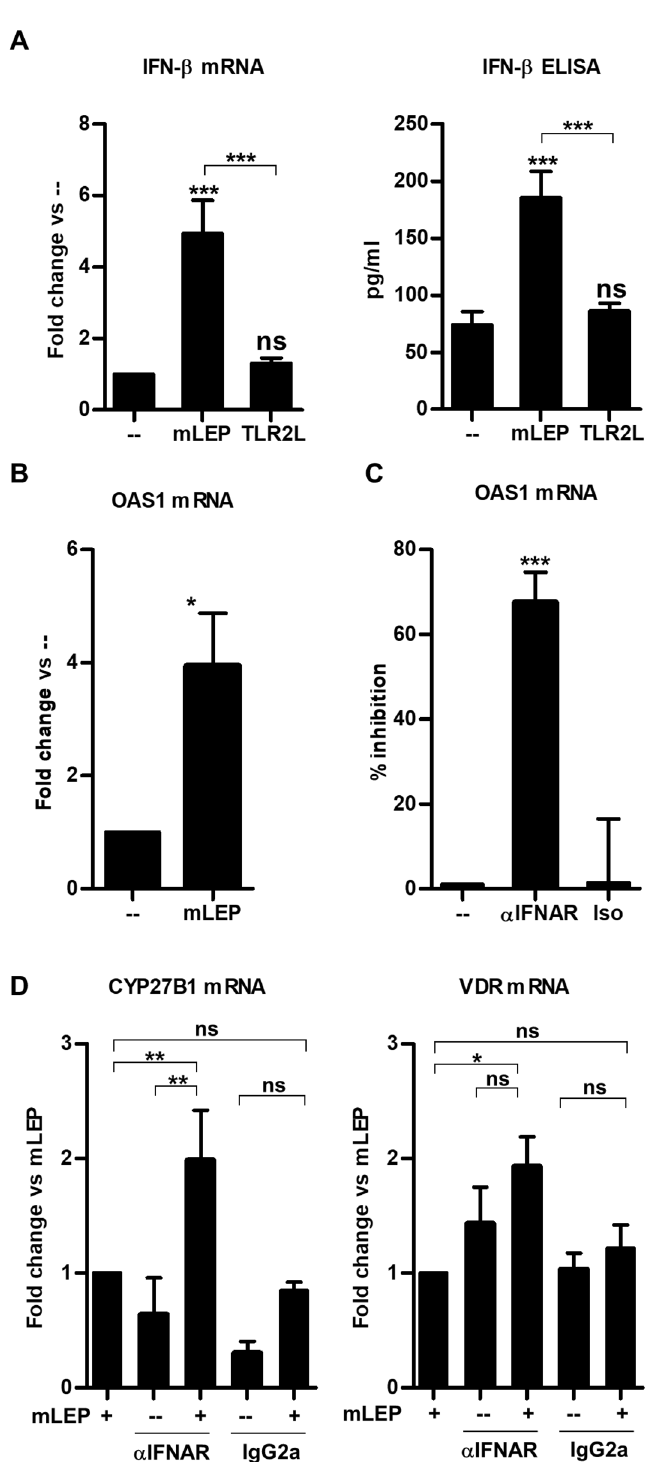
Fig 2. Blocking type I IFN signal during M . leprae infection relieves repression of intrinsic induction of CYP27B1. ( A ) Primary human monocytes were infected with live M . leprae at MOI of 10 for 6 hours for mRNA and 24 hours for culture supernatants. Interferon beta 1 (IFN- β ) expression was measured using quantitative PCR and protein levels measured using ELISA [17]. qPCR data are shown as mean fold change vs. media ± SEM, n = 5, and ELISA are shown as mean concentration ± SEM, n = 5. ( B ) Primary human monocytes were infected with M . leprae at MOI of 10 for 24